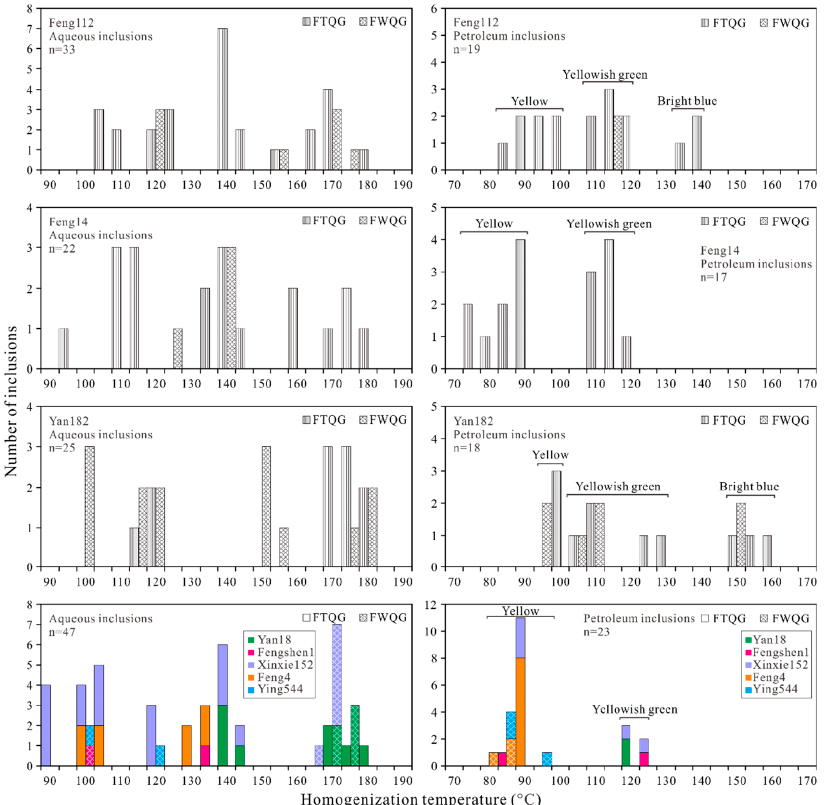
Figure 5. The homogenization temperature histograms of aqueous and petroleum inclusions. T h s of coeval aqueous inclusions of the yellow, yellowish green and bright blue fluo- rescing petroleum inclusions are also a bit different in different wells (Figure 5). In well Feng112, the T h s are respectively between 103.2 °C and 124.5 ° C, between 136.4 °C and 141.7 ° C and between 153.2 °C and 176.1 ° C. In well Feng14, the T h s are respectively be-